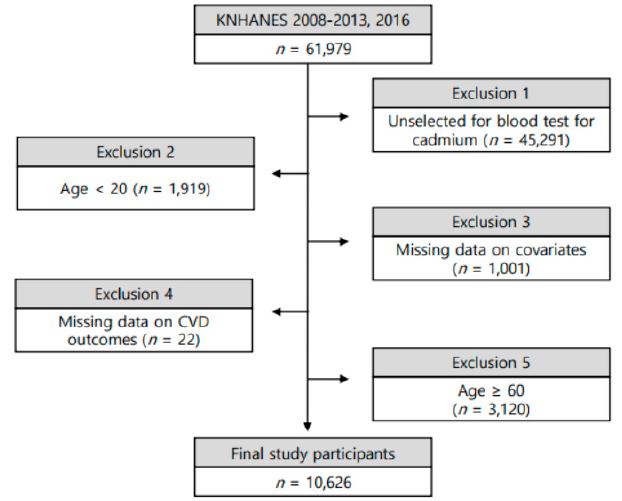
Figure 1. Schematic diagram depicting study population. KNHANES: Korea National Health and Nutrition Examination Survey.